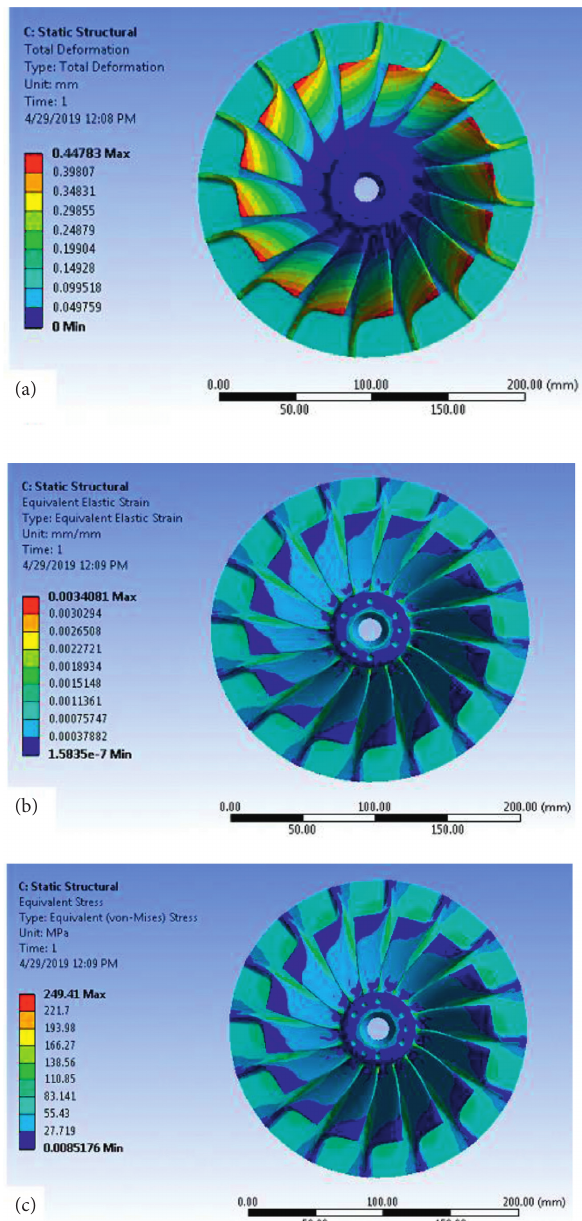
Figure 17: The contour of (a) total deformation (b) Elastic strain (c) Von-Mises stress for pressure difference of 0.5bar in 34500rpm.